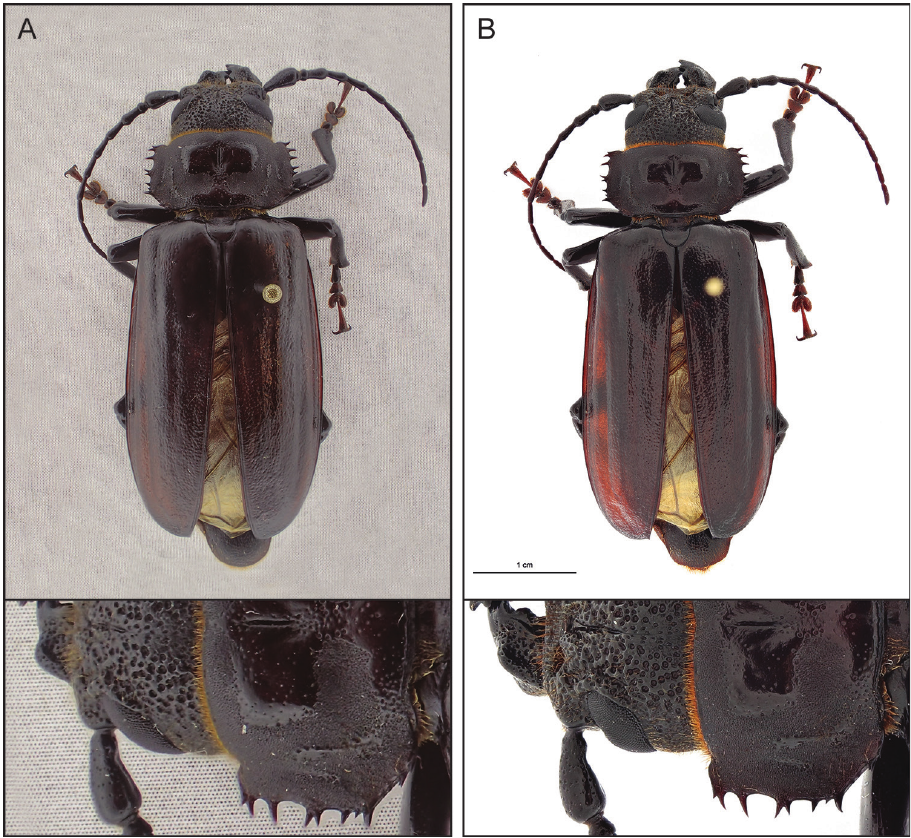
Figure 3. Comparison of image quality between the compact camera ( A ) and the professional setup ( B ) with the specimen occupying the same proportion of the frame. A detail is shown below. The compact camera was set up 5 cm from the specimen with the optical zoom at 1×, 29 images (narrow setting) were manually stacked. The professional setup outperforms the compact camera, producing a sharper image when specimens larger than a few centimetres are set to fill the frame